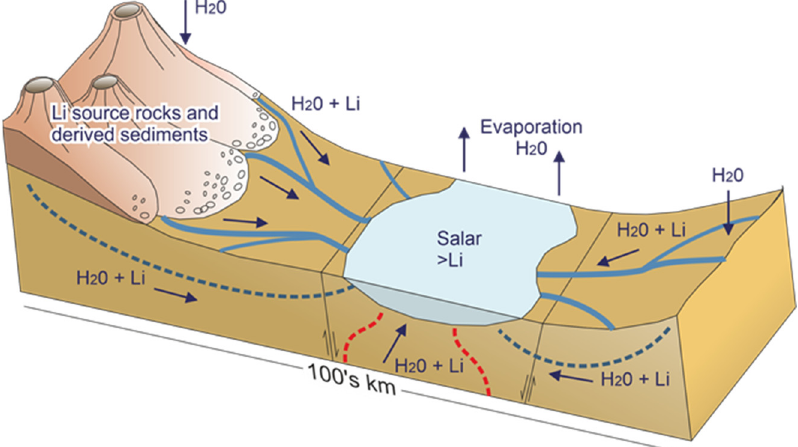
Figure 3. Schematic illustration of the salar and catchment, showing potential sources of lithium (weathering of volcanic bedrock and derived sediments) in the upper part of the drainage basin, coinciding with areas of higher precipitation; pathways for surface water and groundwater flow that transports lithium from source areas to the salar (blue lines); and the salar where lower precipitation and higher evaporation result in the concentration of inflowing water to create lithium-enriched brines. Other potential sources of lithium exist, including direct input from hydrothermal sources (red lines).